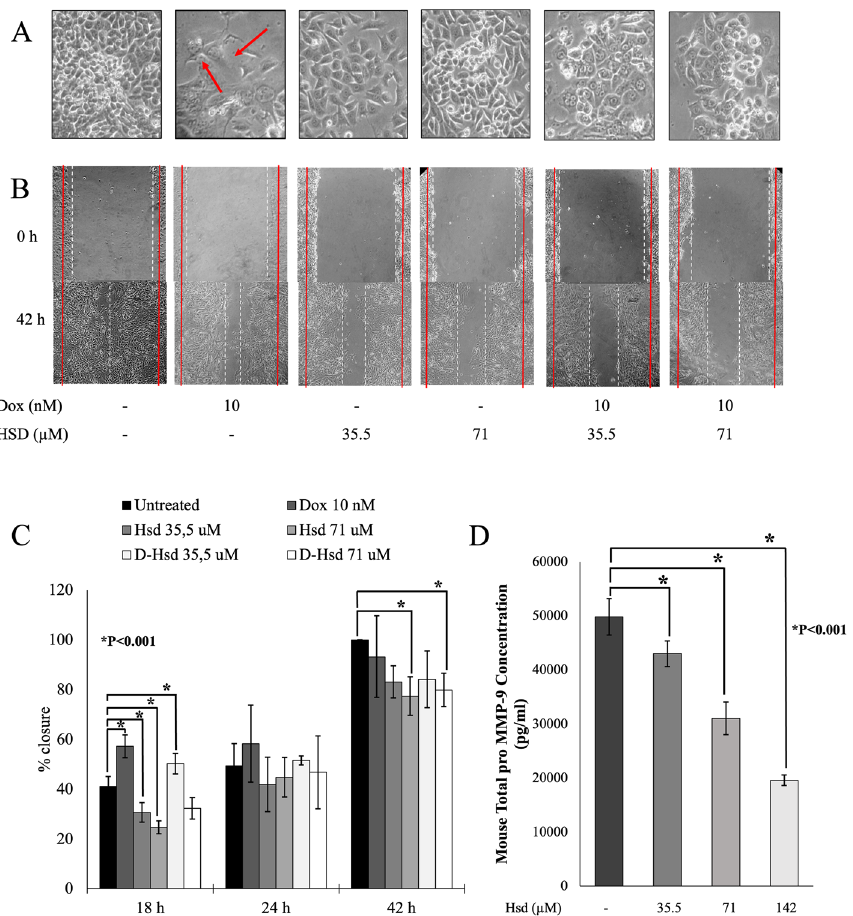
Fig. 3 Effect of Hsd, DOX, and combination treatment on the migration ability of 4T1 breast cancer cells. A After treatment, the formation of lamellipodia was observed under inverted microscopy ( 100 magnification). The red arrows that there are morphological differences. B × Cell migration was assessed via scratch wound healing assay. C The migration abilities were quantified by counting the area of closure using ImageJ, and the percentage of the treated group compared to the untreated group is presented as the mean SD of the triplicate independent ± experiment. D The expression level of pro MMP-9 protein was measured by ELISA. The quantitative data were shown as the mean SD of the ± triplicate independent experiment. * p < 0.001 (post-hoc LSD test between each group) was considered statistically